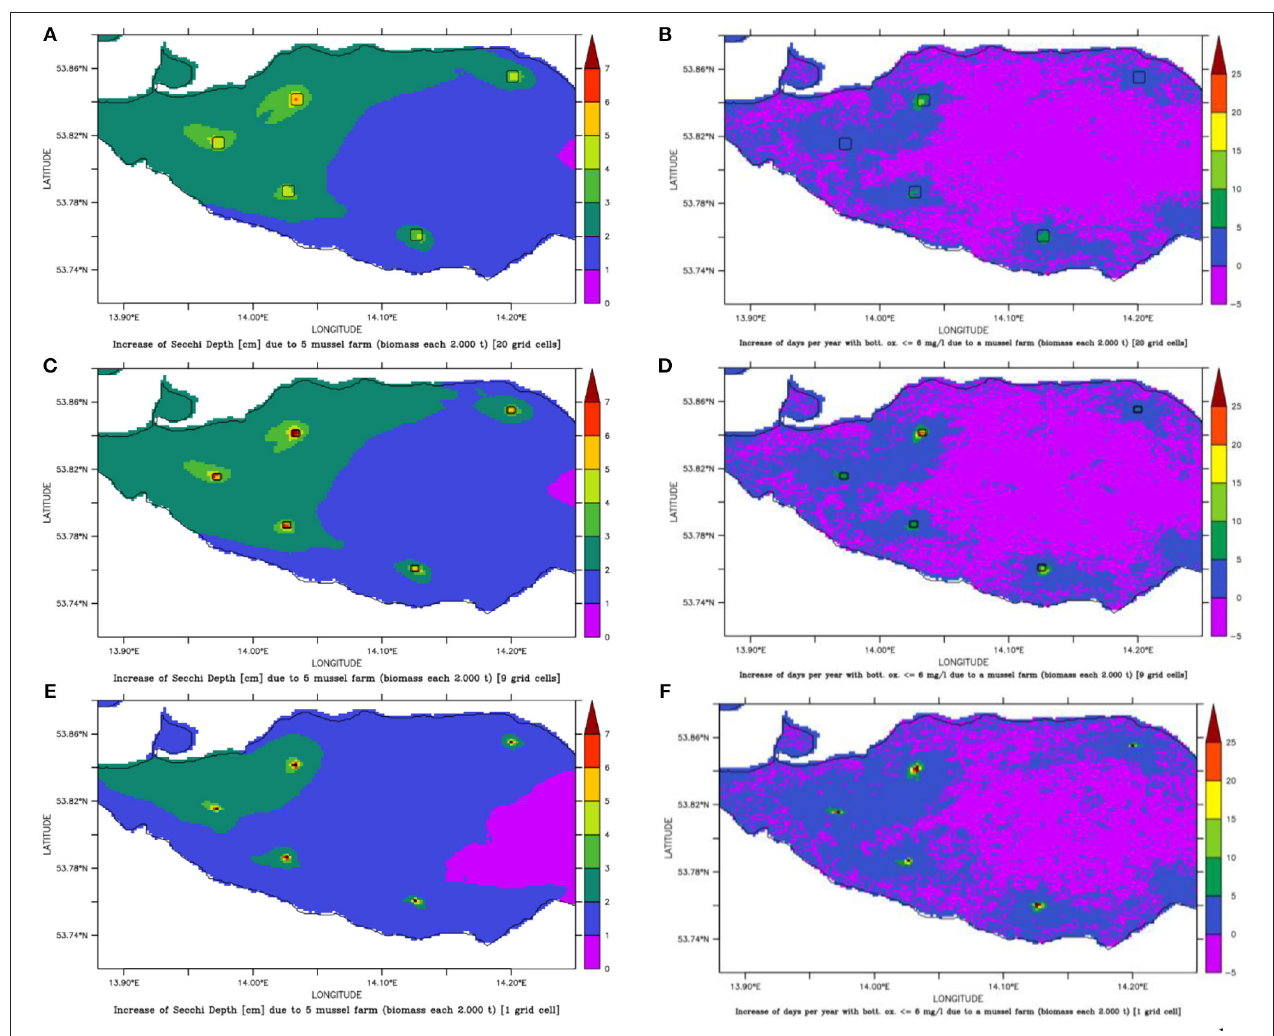
FIGURE 10 | Change of Secchi Depth (A,C,E) and days per year with bottom oxygen below 6mg l − 1 (B,D,F) for mussel farm option 3 with 5 small scale farms (framed areas) of different sizes: either 0.45 km 2 (A,B) , 0.2km 2 (C,D) or 0.02 km 2 (E,F) .